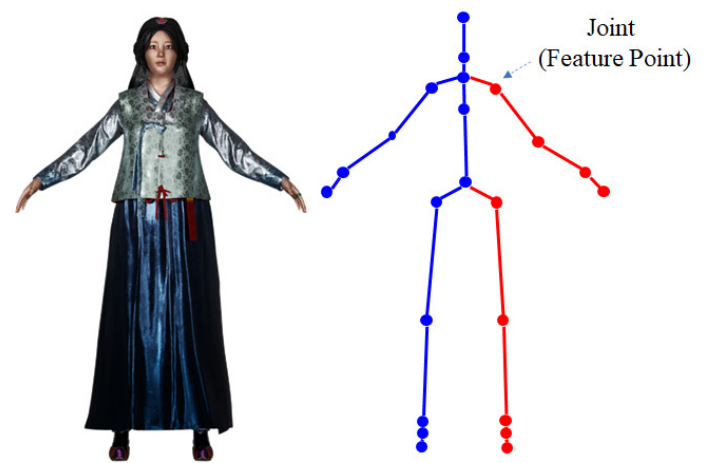
Figure 2. Joints as feature points in human pose